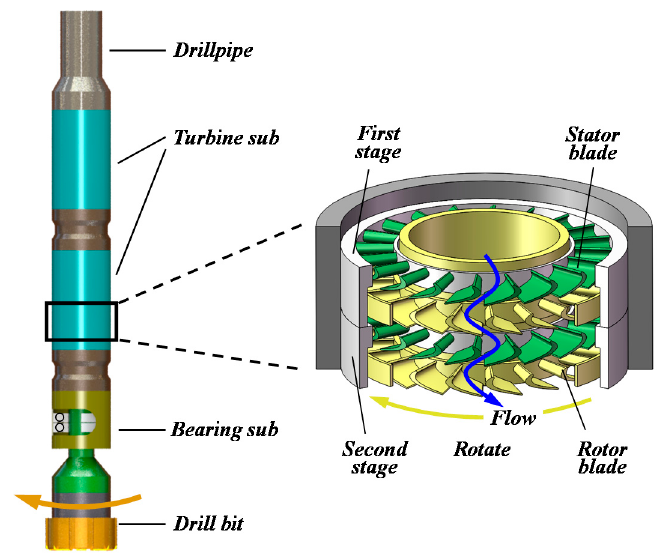
Figure 1. Typical turbodrill schematic.